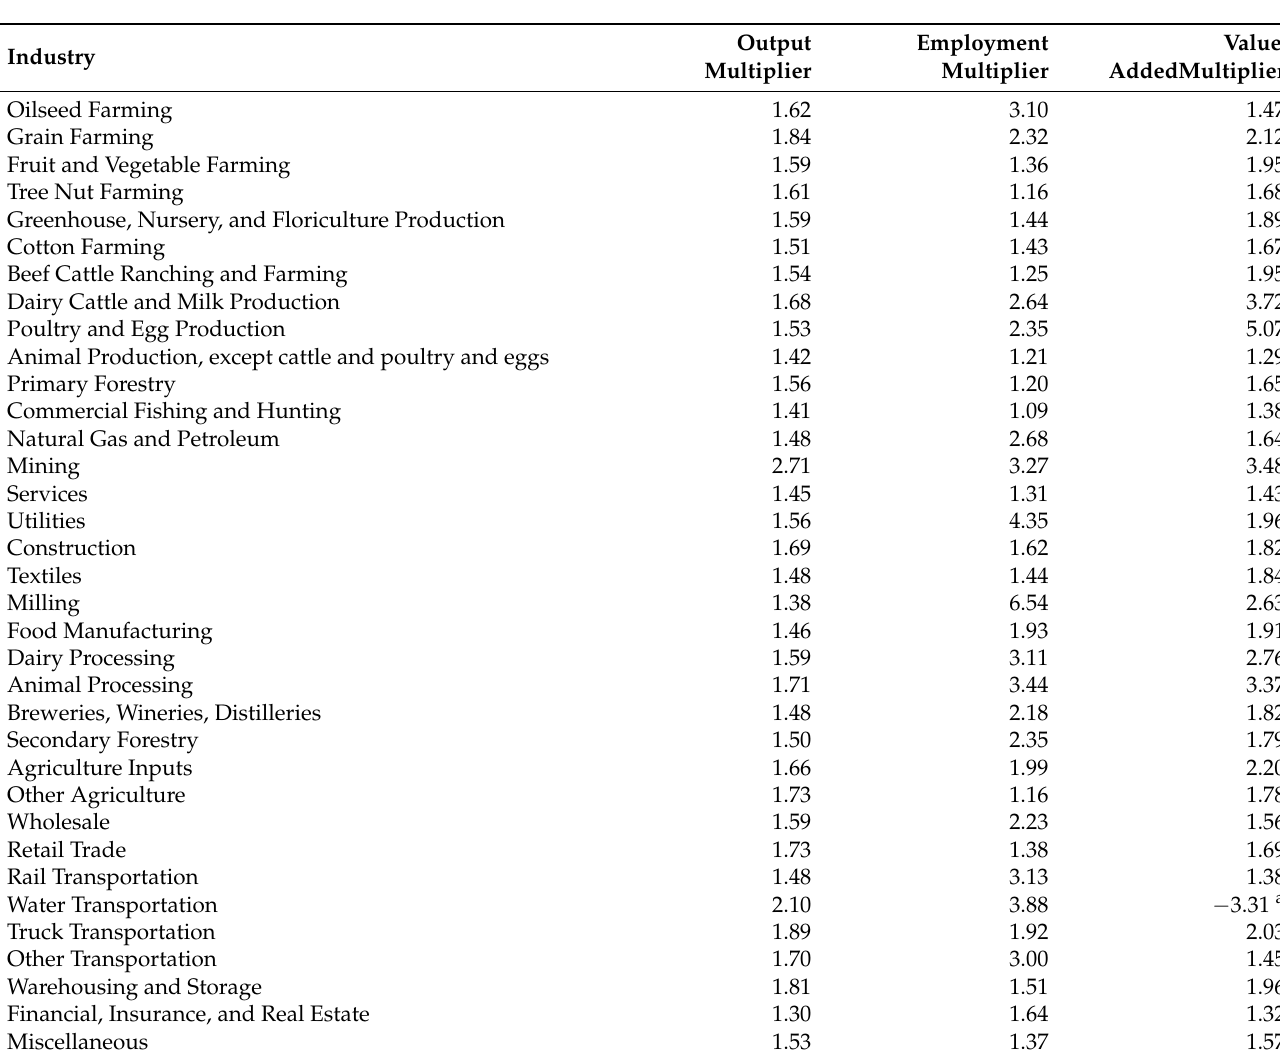
Table A2. Multipliers by